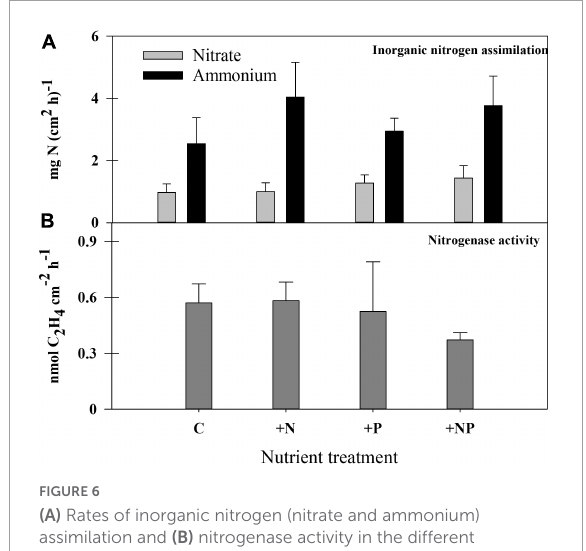
FIGURE6 (A) Rates of inorganic nitrogen (nitrate and ammonium) assimilation and (B) nitrogenase activity in the different treatments at the end of the